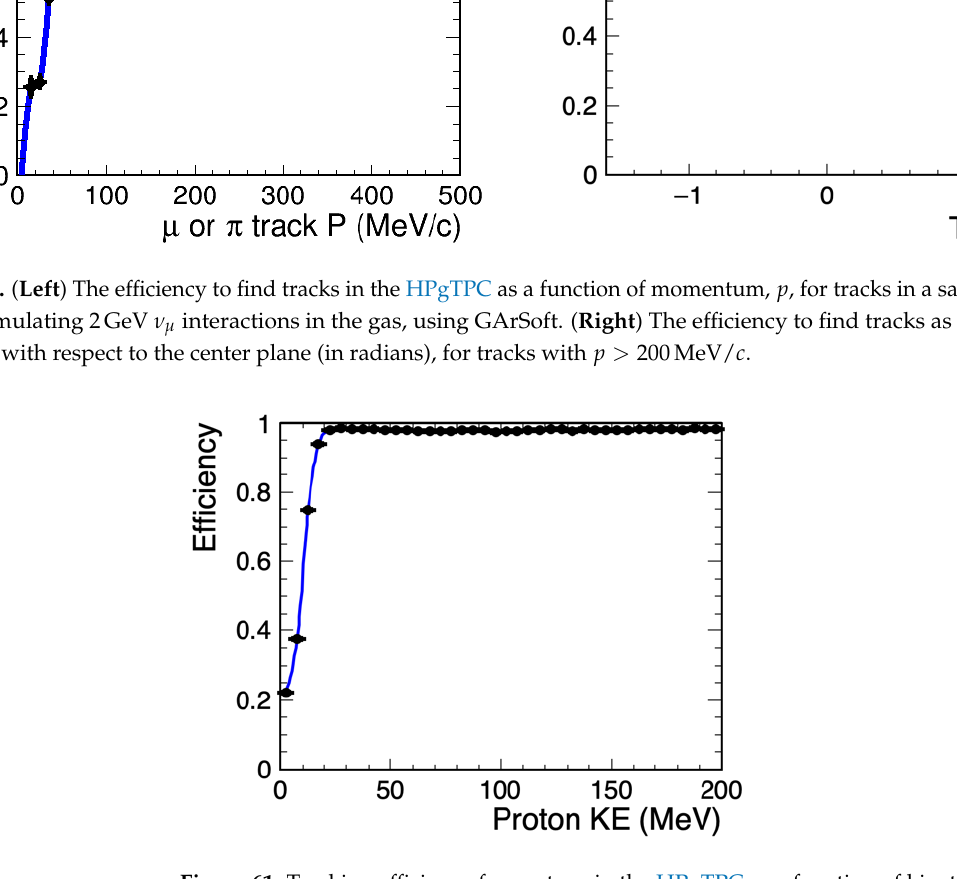
Figure 61. Tracking efficiency for protons in the HPgTPC as a function of kinetic